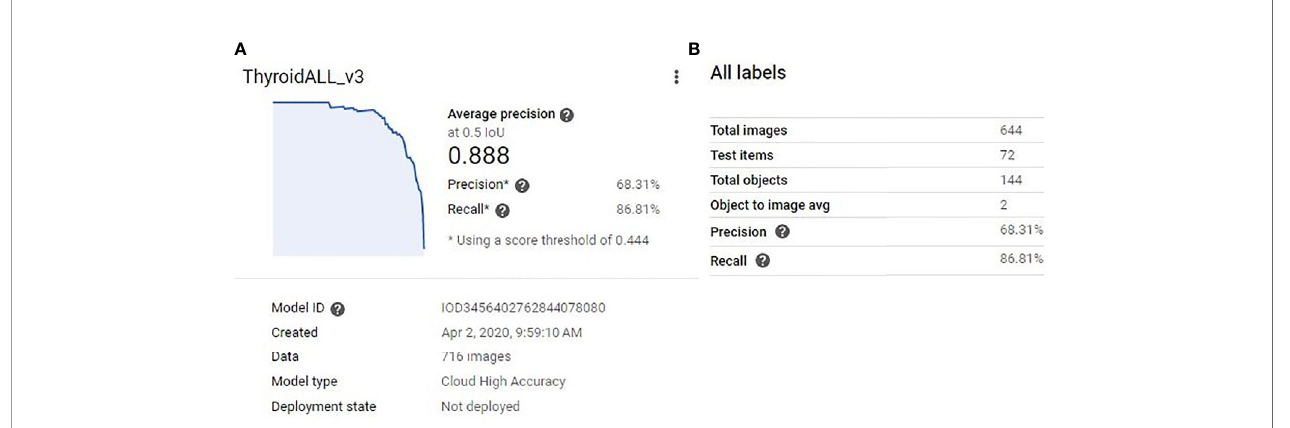
FIGURE 2 | (A) The model performance report generated by the platform. The model had an AUC of 0.889. (B) The model split the 716 training images into new training (644 images) and new testing (72) datasets. At a con fi dence score level of 0.44, the model had 68.31% precision and 86.81% recall for the new testing (72 images)